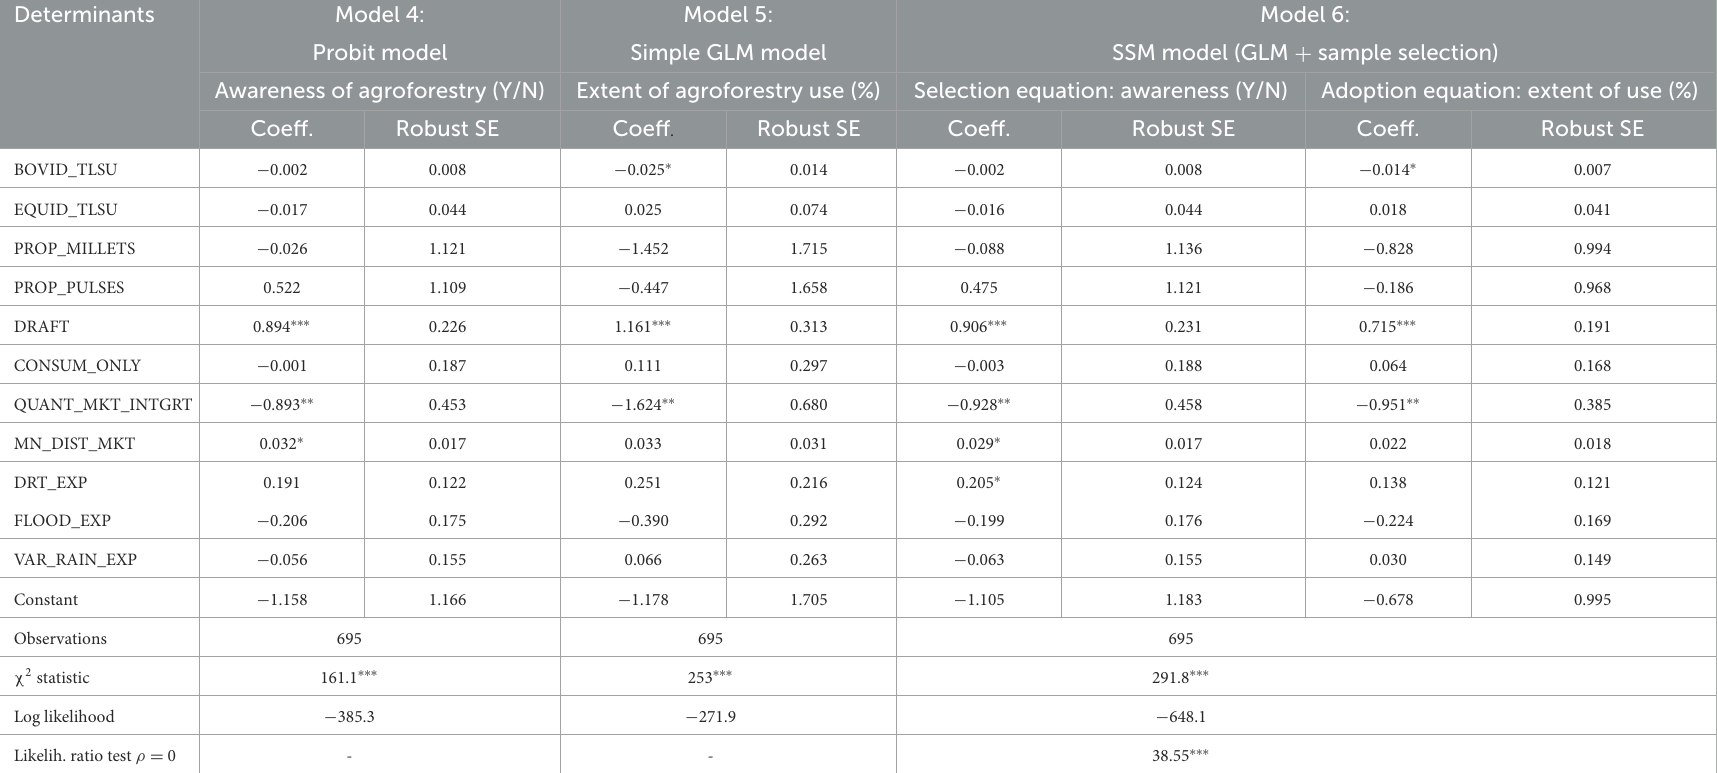
AbbreviationsofpracticesareexplainedinTable2;locationdummiesareomitted; ∗ p < 0.10, ∗∗ p < 0.05, ∗∗∗ p <